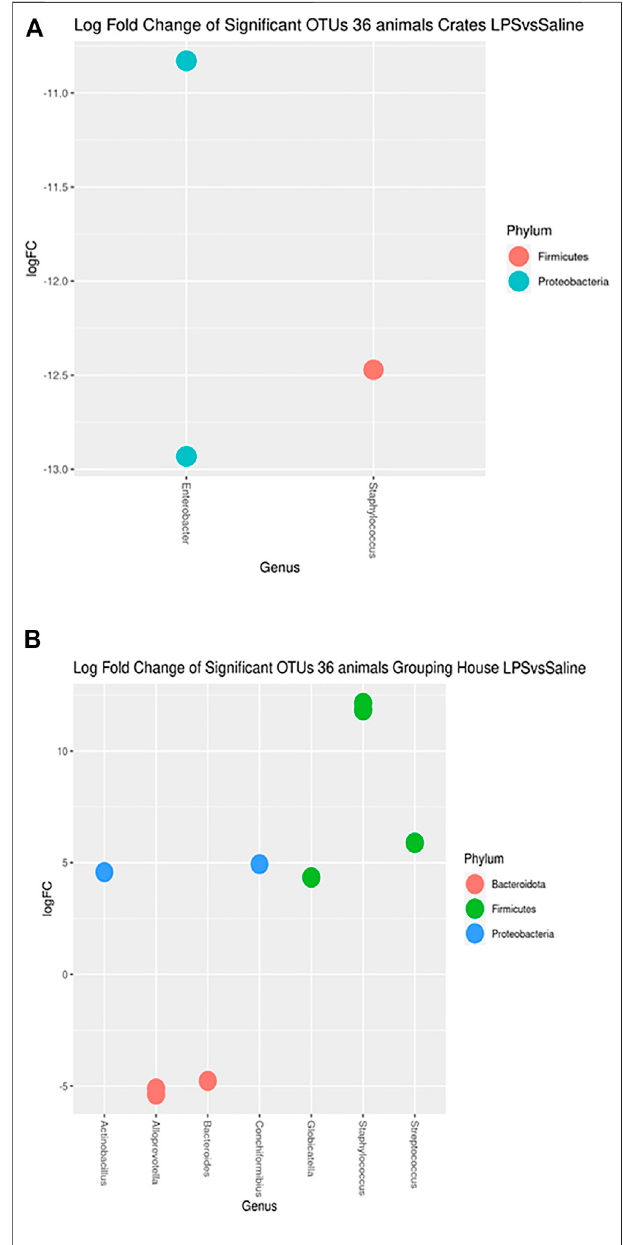
FIGURE 4 | Log fold changes of signi fi cant OTUs after LPS or SAL challenge in the different housing systems: crates (C) – n = 9; indoor group- housing (GH) – n = 14; and outdoor group-housing (OD) – n = 13. (A) Negative values correspond to C-SAL animals ( n = 5). (B) Positive values correspond to GH-LPS animals ( n = 6), and negative values correspond to GH-SAL animals ( n =